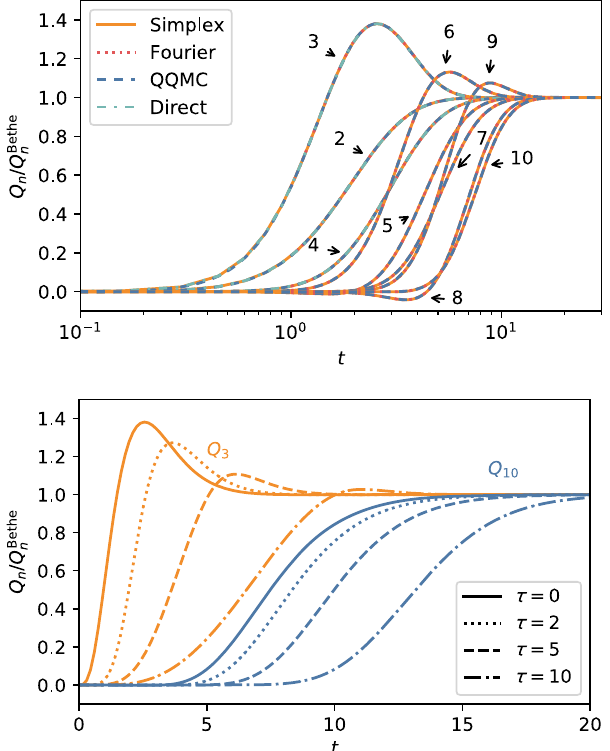
t Þ after a quench at t ¼ 0 for the SIAM model at FIG. 10. Q n ð ϵ α ¼ 0 , in equilibrium. The coefficients are normalized by d ¼ t ¼ ∞ Þ ¼ Q Bethe their exact asymptotic values Q . Upper: n ð n abrupt quench λ ð t Þ ¼ θ ð t Þ . Different curves correspond to dif- ferent integration techniques, with indistinguishable results: FIG. 11. Charge Q ð U; t Þ on the dot for the SIAM model after simplex integration (55) (yellow continuous line), Fourier tech- switching on the interaction abruptly (yellow solid line, τ ¼ 0 ) or nique (H4) (red dotted line), quantum quasi-Monte-Carlo smoothly (blue dashed line, τ ¼ 2 ) with λ ð t ≤ τ Þ ¼ sin ð π t= 2 τ Þ (QQMC) [33] (blue dashed line), and direct numerical integration t Þ up to n ¼ 14 . and λ ð t ≥ τ Þ ¼ 1 . Both curves include terms Q of Eq. (42) for n ¼ 2 , 3, 4 (green dashed-dotted line). The arrows n ð The black dotted line corresponds to the resummed series using t Þ for n ¼ 3 (orange) and indicate the value of n . Lower: Q n ð n ¼ 10 (blue) using a continuous increase of the interaction the Euler transform of the first 20 Q Bethe coefficients, as n α ¼ 0 with strength λ ð t Þ ¼ sin ð π t= 2 τ Þ for t < τ , and λ ð t Þ ¼ 1 , for t ≥ τ (with in Ref. [25]. In all calculations, we use ϵ d ¼ 20 simplex integration). U ¼ 2 ; t M ¼